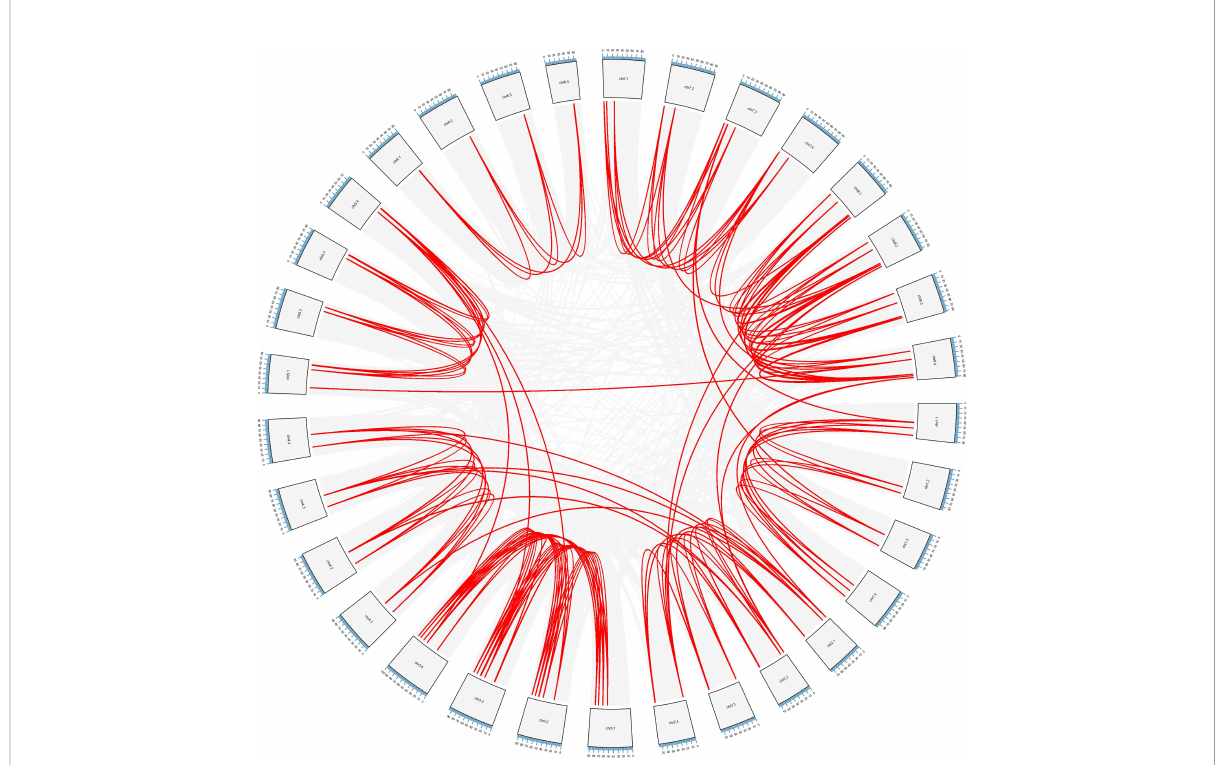
FIGURE 5 Schematic diagram of the inter-chromosomal relationships of MsLEA_2 genes. Chromosome numbers are indicated at the outer edge of the circle, while the scale represents megabases (Mb). The lines inside indicate duplicated gene pairs. The red lines represent collinear pairs of the MsLEA_2 genes, while the gray lines indicate collinear pairs of all alfalfa